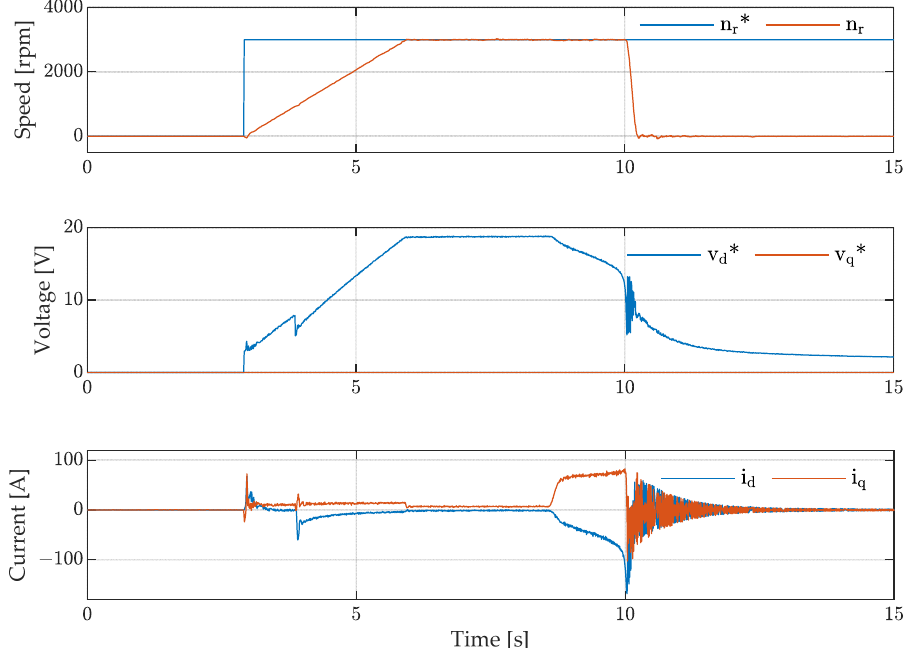
Figure 22. Ramp ‐ up and ramp ‐ down with the nominal reference speed and 75% load applied at Figure 22. Ramp-up and ramp-down with the nominal reference speed and 75% load applied at steady ‐ state, with a required power factor of 1: speed, dq voltages, dq currents. steady-state, with a required power factor of 1: speed, dq voltages, dq currents.